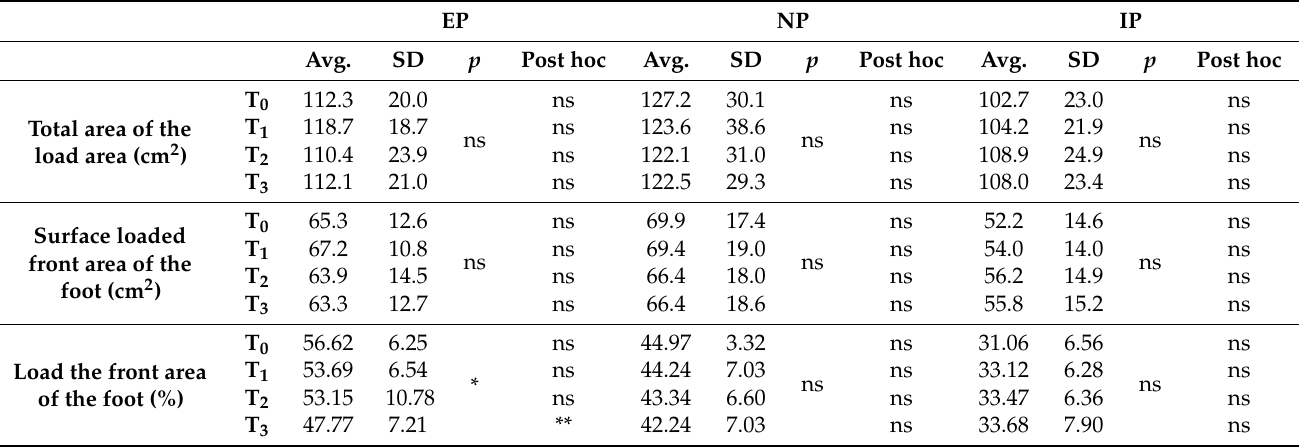
Table 5. Foot pressure surface parameters in subgroups EP—with excessive pressure; NP—with normal pressure; and IP—with insufficient pressure before (T 0 ) and after 1 (T 1 ), 2 (T 2 ), and 3 (T 3 ) treatment. Avg.—average; SD—standard deviation; p —level of significance; ns—not significant;